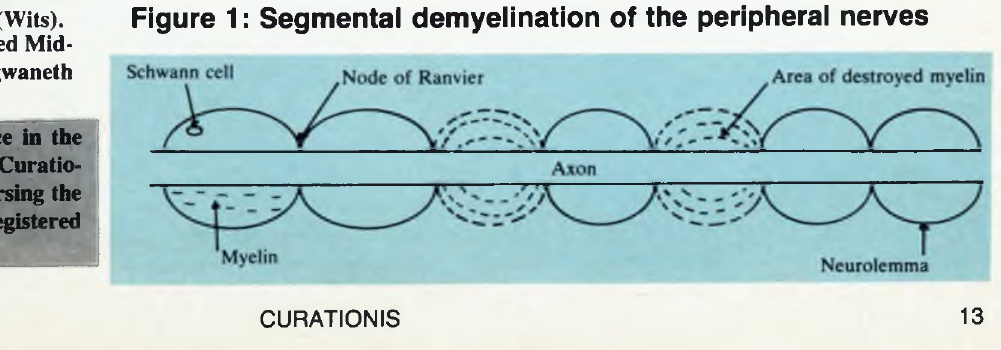
Figure 1: Segmental demyelination of the peripheral